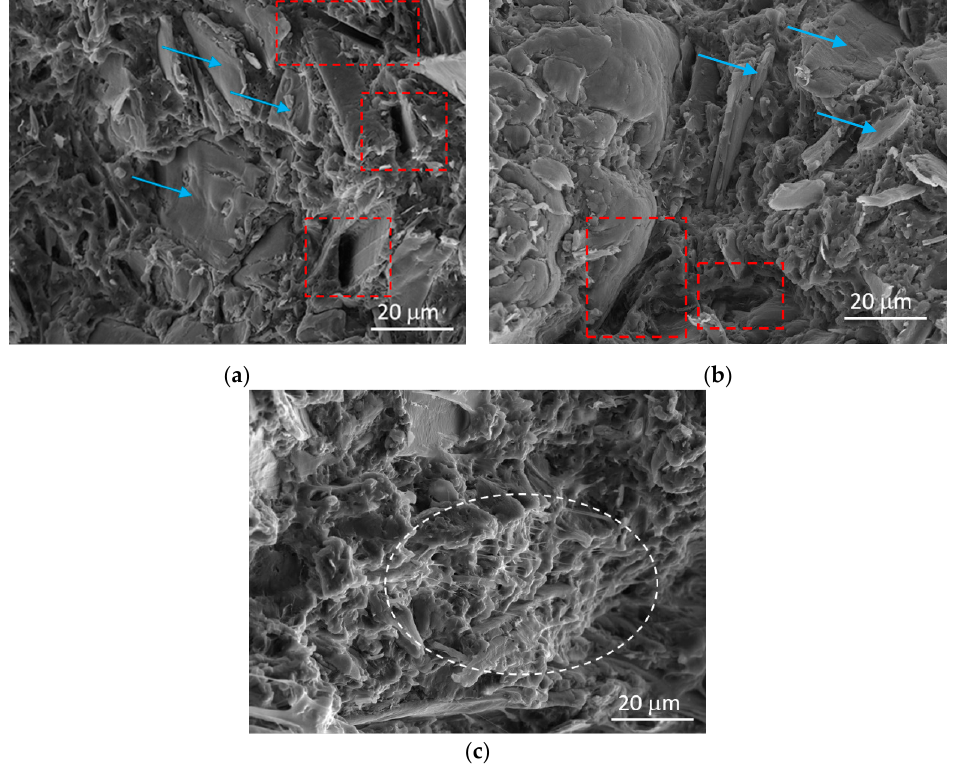
Figure 6. SEM micrographs of ( a ) 0 wt.%, ( b ) 10 wt.%, and ( c ) 20 wt.% in a flood fed condition at 25 RPM. The polymer ligaments can be identified by a white dotted ellipse, wood fibers by blue arrows, and sites of fiber pull ‐ out by red dotted squares.